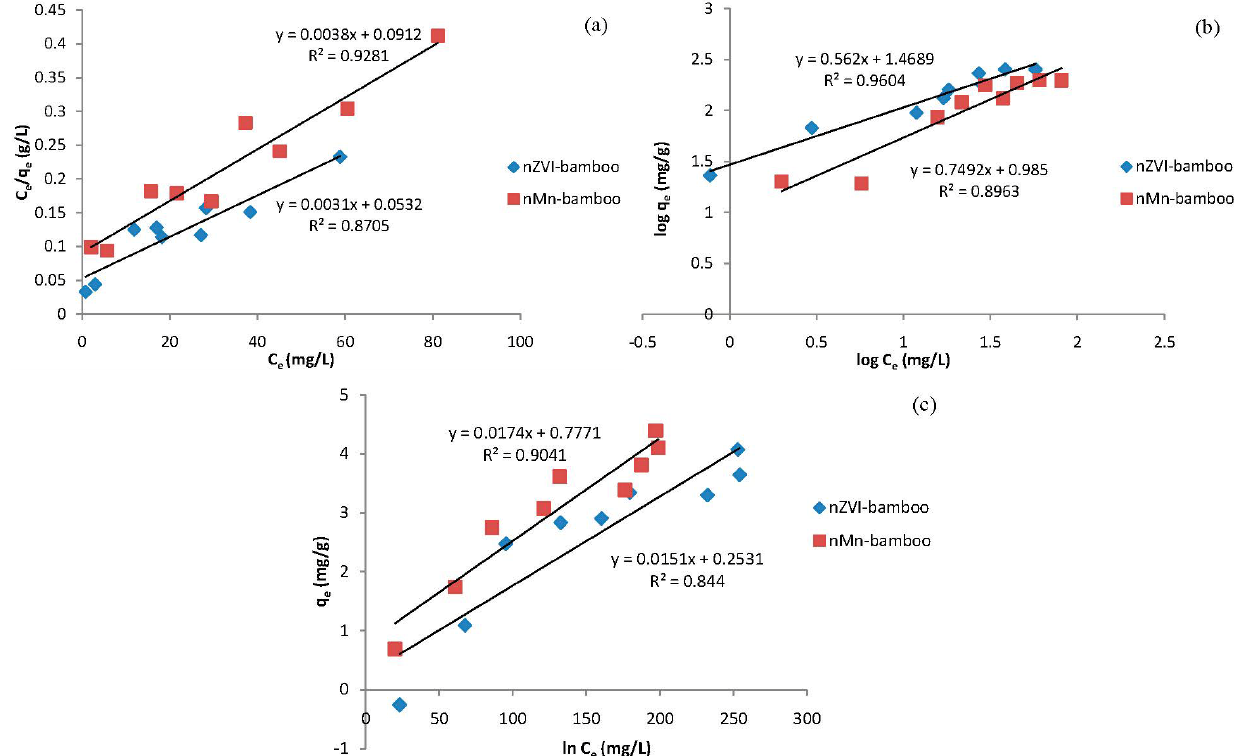
Figure 6. ( a ) Langmiur; ( b ) Freundlich; and ( c ) Temkin Isotherms for the adsorption of MB onto nZVI-bamboo and nMn-bamboo composites.